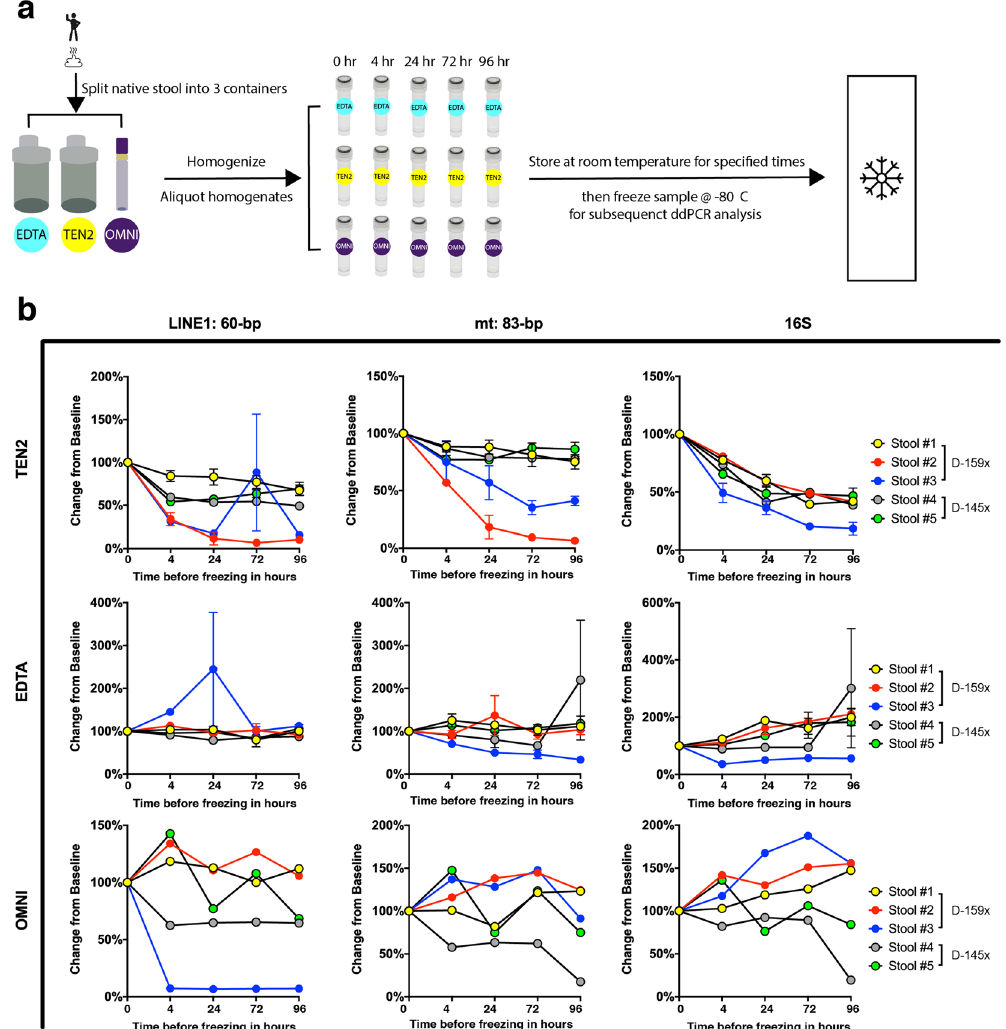
Figure 5. Evaluation of three different stool preservative solutions for host DNA stabilisation at room temperature. ( a ) Schematic diagram of stool processing for the stool DNA stability experiment and ( b ) Effectiveness of different stool preservation solutions on endogenous DNA stability. Change in ACN per μ l stool DNA extract from baseline (time 0) of LINE-1 (left), mt (ND5) (middle), and 16S (right) DNA are plotted for varying incubation times of stool specimens at room temperature. TEN2- and EDTA-preserved stools were DNA extracted and analyzed in duplicate; the error bars represent standard errors from ddPCR of two replicate extractions for each time point. The OMNI-preserved stool provided enough material only for one extraction per time point and therefore error bars are not